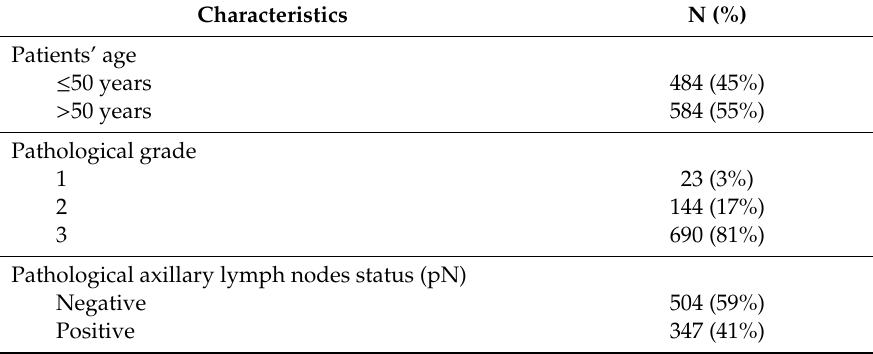
Table 1. Description of the triple negative breast cancer (TNBC)